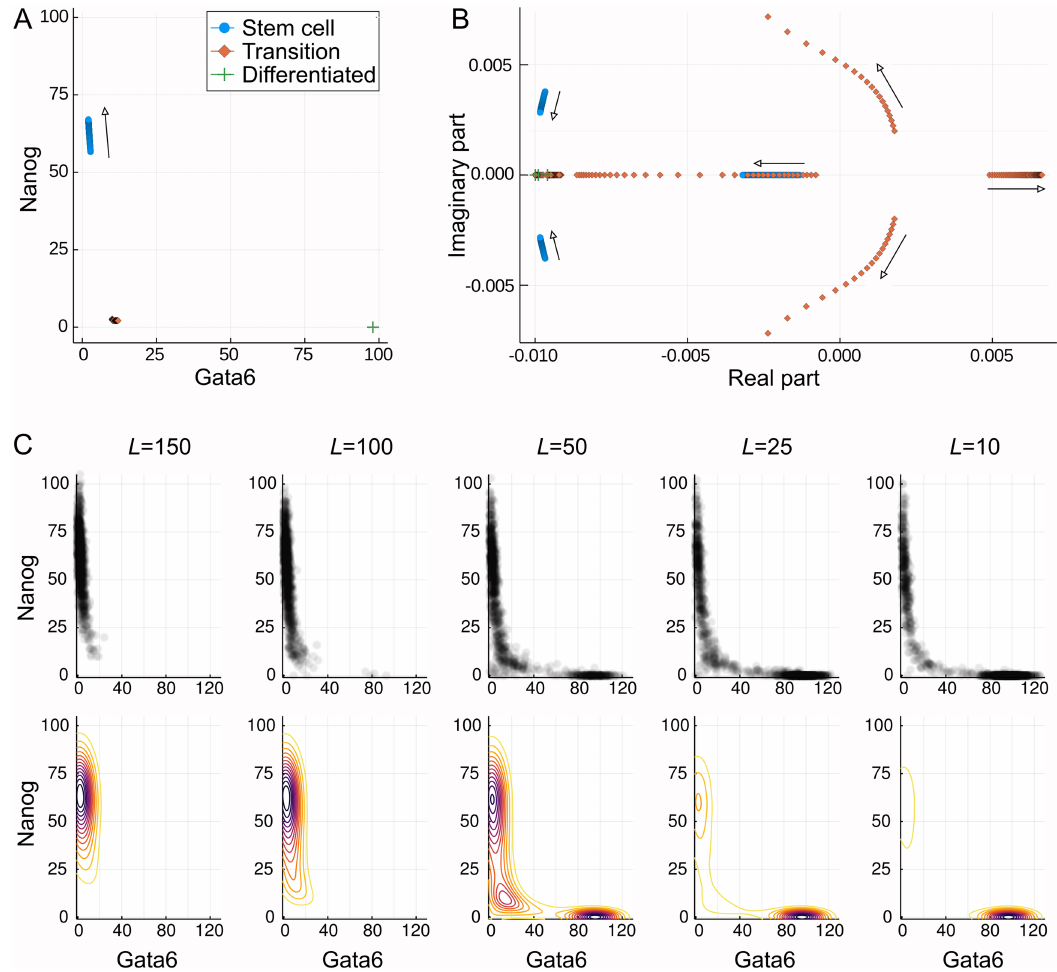
Fig 7. Varying behaviour of the system with LIF concentration, L . (A) Three of the fixed points of the model with increasing L . The differentiated and transition state remain unchanged while the stem cell state moves to higher Nanog values. (B) The eigenvalues of the Jacobian at each of the three fixed points as L increases. The stem cell state becomes locally more stable, as indicated by the increasingly negative eigenvalues. The transition state becomes increasingly unstable, thereby making transition to this state less probable. The differentiated state is unaffected, but is seen to be locally more stable than the stem cell state. Complex eigenvalues are associated with rotational “curl” dynamics. (C) Variation of the probabilistic landscape. Upper plots show a sample of the sampled points while lower plots show the landscapes. As L decreases the valley at the differentiated state becomes deeper while that at the stem cell state becomes shallower. At intermediate values the landscape is flatter around the transition state.